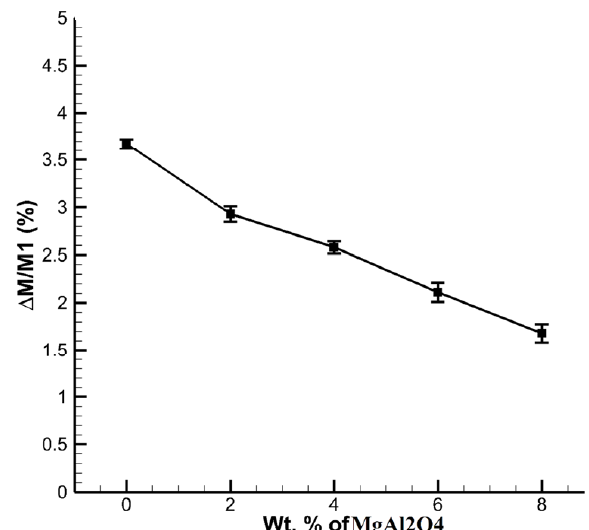
Fig. 5 Effect of Nano-spinel addition on improvement of hydration resistance of MgO-CaO refractories [111].